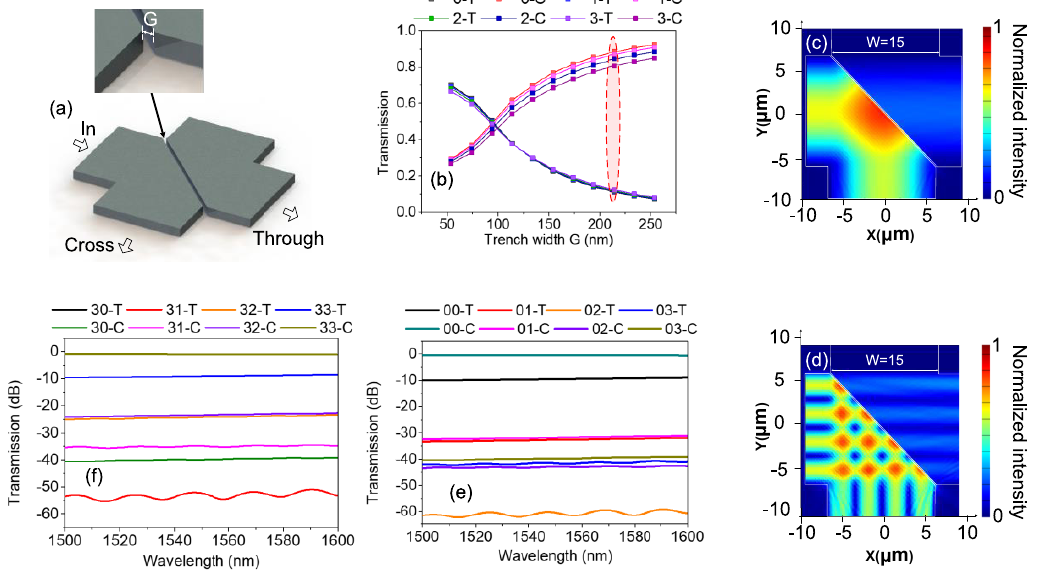
Figure 2: (a) Structure of the coupling region. (b) Simulated transmission efficiency for TE 0 – TE 3 modes with different trench gaps. Simulated light propagations for (c) TE 0 and (d) TE 3 mode input and corresponding transmission spectra for (e) TE 0 and (f) TE 3 mode input from 1500 to 1600